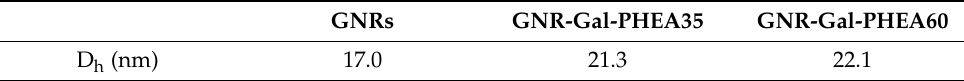
Figure 4. 90 ◦ light scattering fractograms of GNRs, GNR-Gal-PHEA35 and GNR-Gal-PHEA60. Figure 4. 90° light scattering fractograms of GNRs, GNR-Gal-PHEA35 and GNR-Gal-PHEA60. Table 6. Hydrodynamic diameter D h determined via Table 6. Hydrodynamic diameter D h determined via EAF4-MALS.